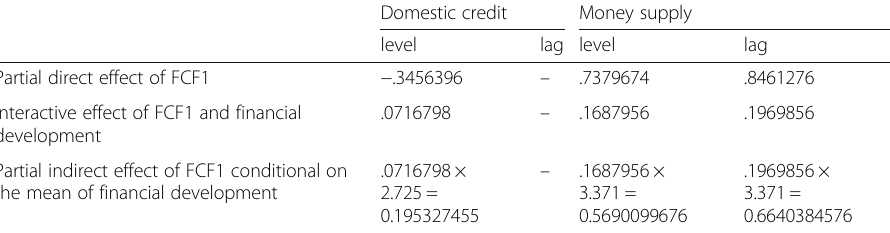
Table 17 Foreign capital inflows (fc1 = pc1 = comp1), of which portfolio registers the highest eigenvector of 0.6796, interacts with financial